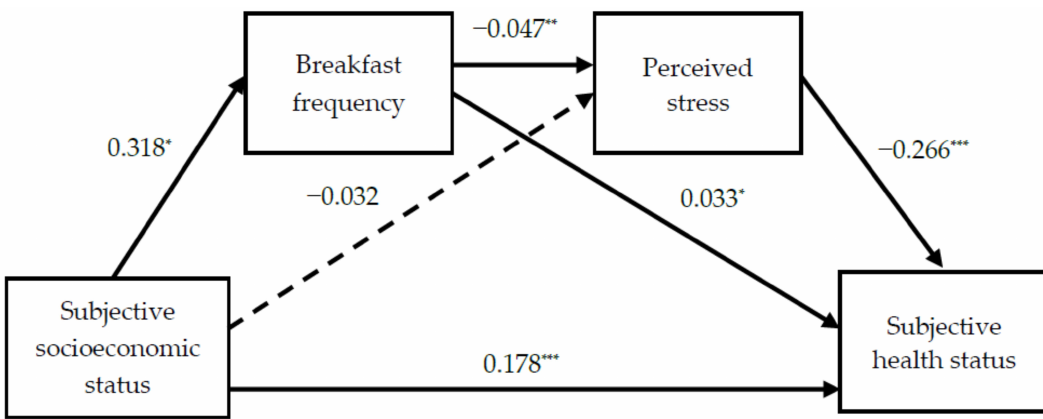
Figure 1. The pathways and coefficient. Solid lines represent significant pathways. The dotted line represents a non- significant pathway. * p < 0.05, ** p < 0.01, *** p <